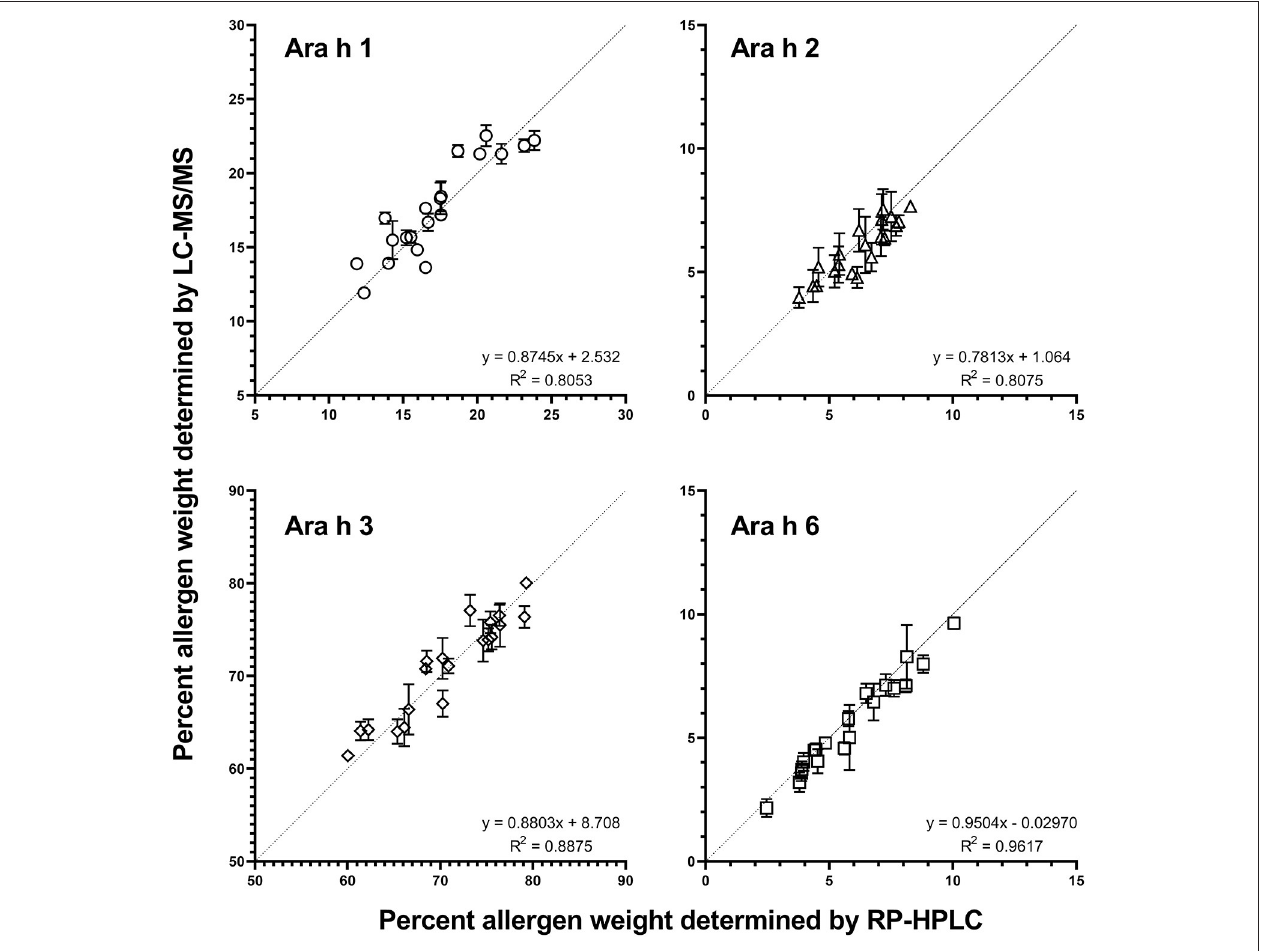
FIGURE 2 | Comparison of Ara h 1, 2, 3, and 6 percentages as determined by RP-HPLC (1) vs. LC-MS/MS detection. The average percent protein weight in each genotype [allergen (g)/total protein (g)] for each allergen family as determined by RP-HPLC ( x -axis) vs. LC-MS/MS ( y -axis) family is shown. Each data point represents one genotype. Each measurement represents the mean and standard error of two biological replicates (each with 2 technical replicates for LC-MS/MS). The correlation coefficient (RP-HPLC vs. LC-MS/MS) for all allergens and all peanut genotypes was 0.9966 (best fit y